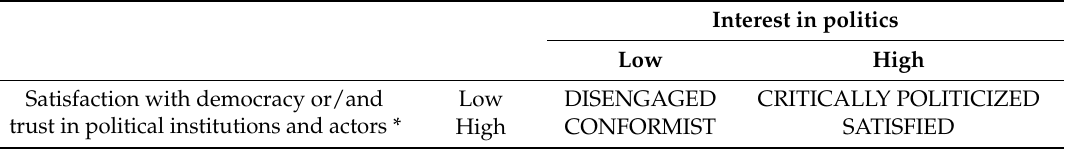
Table 1. A typology of attitudes towards